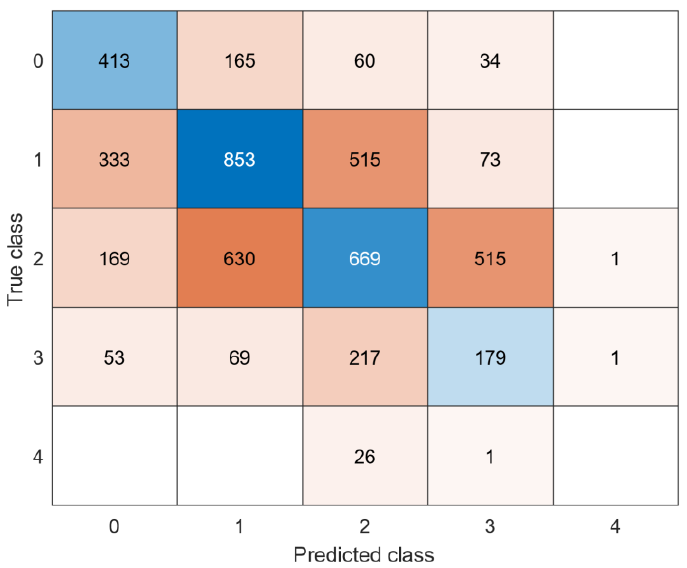
Figure 5. Confusion matrix: generalized model of upper extremities dystonia.